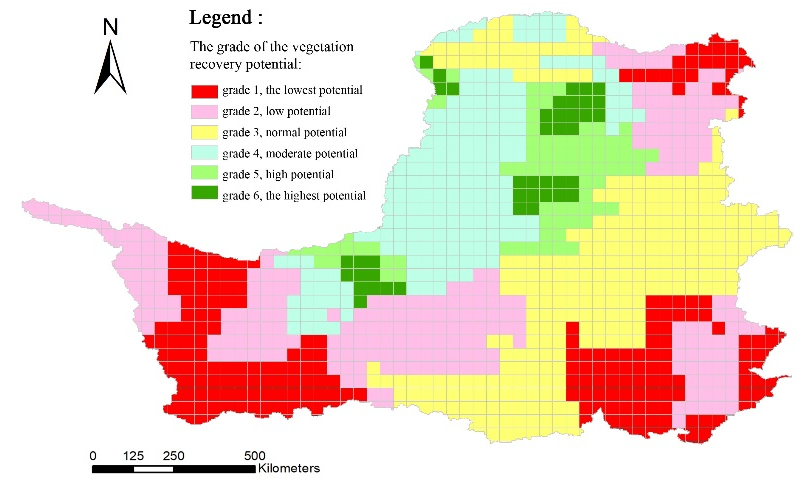
Figure 11. The grade of the vegetation recovery potential in the Loess Plateau.